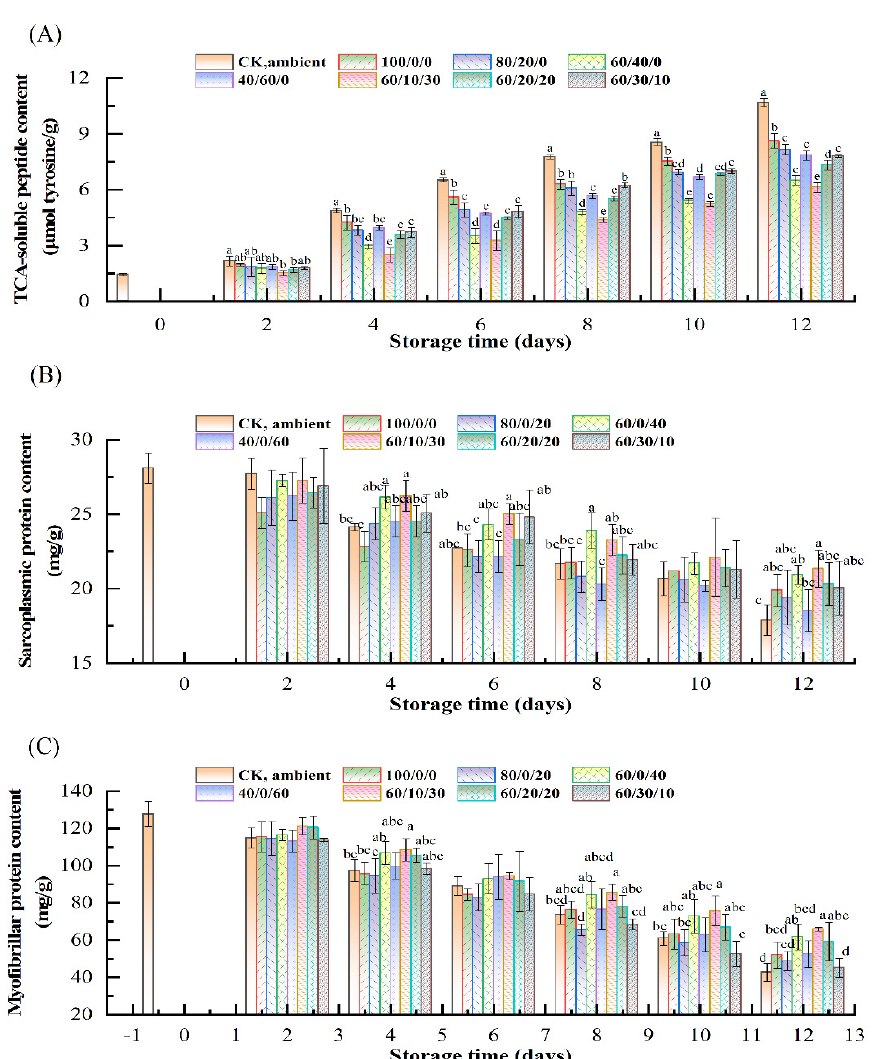
Figure 4. Changes of TCA-soluble peptides ( A ), sarcoplasmic protein content ( B ), and myofibrillar protein content ( C ) of salmon under MAP containing different CO 2 /O 2 /N 2 ratios at 4 °C. Different lowercase letters (a–c) represent significant differences ( p < 0.05) between different groups at the same storage period.